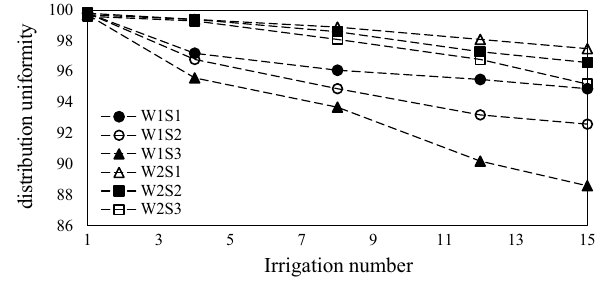
Fig. 6 Variations of distribution uniformity during the experiment period